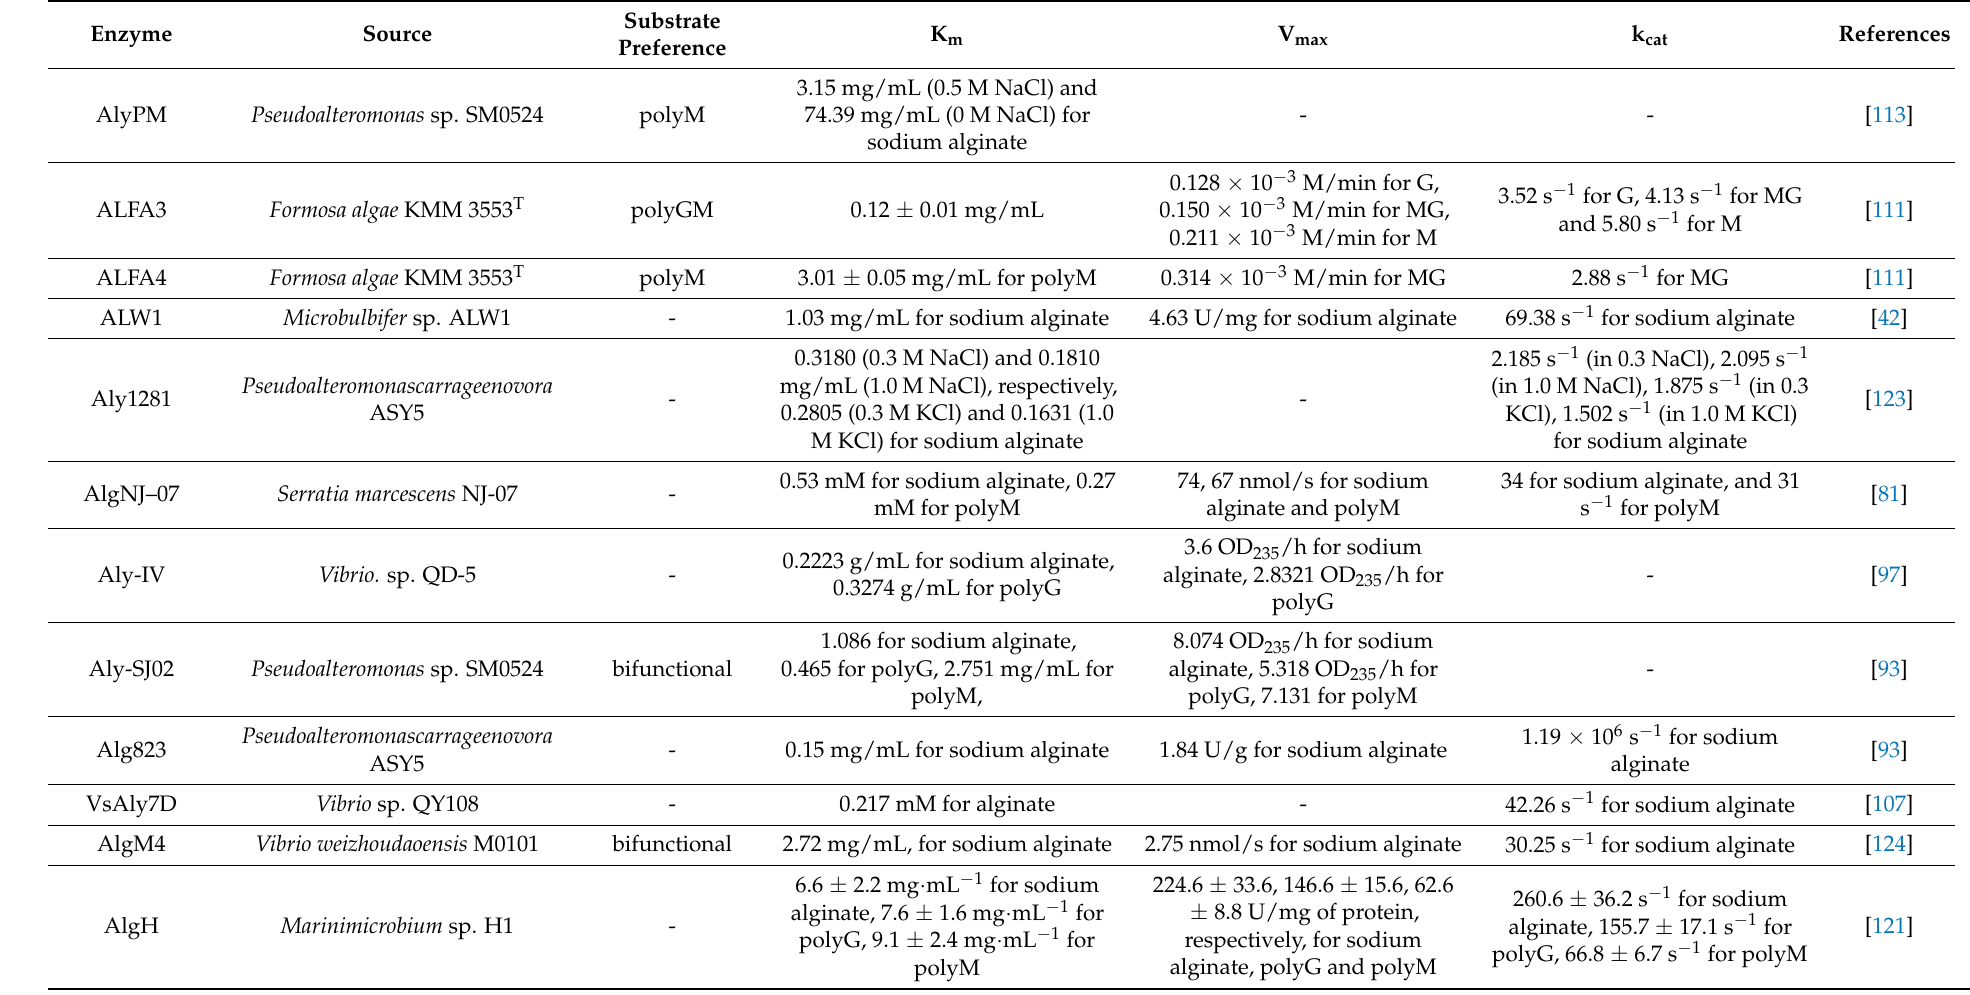
Table 3. Kinetic parameters of alginate lyases from marine bacteria toward sodium alginate, polyM, and